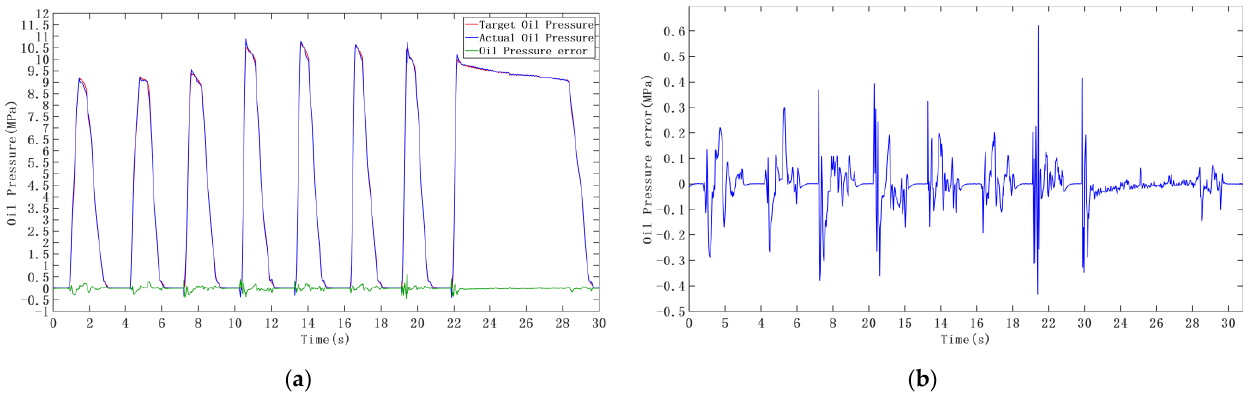
Figure 21. Results of oil pressure following control based on traditional PID controller under gen- eral braking conditions: ( a ) Target oil pressure, actual oil pressure and oil pressure error. ( b ) Oil pressure error.